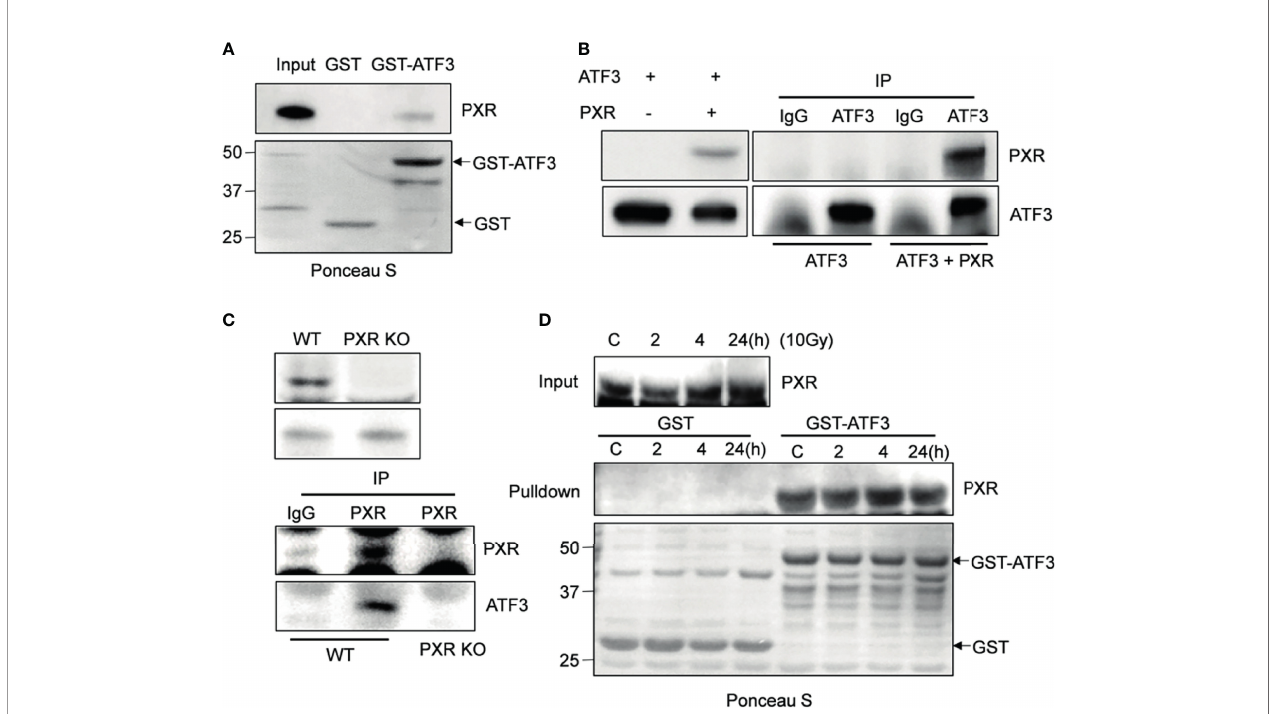
FIGURE 1 | PXR interacts with ATF3. (A) PXR interacted with GST-ATF3. 1 m g GST or GSTATF3 protein was immobilized onto 20 m l glutathione agarose beads, and then incubated with 5 m l in vitro translated PXR. GST-pulldown assay was performed. (B) Interaction between PXR and ATF3 revealed by reciprocal co-IP experiment. H1299 cells in 60 mm3 dish were co-transfected with 3 m g FLAG-PXR, and/or pCG-ATF3. The immunoprecipitation assay was performed using 1 m g IgG antibody or ATF3 antibody. (C) Interaction between PXR and ATF3 con fi rmed by endogenous co-IP assay. 3 mg wild-type and PXR-knockout (KO) LS180 cells were harvested, and PXR antibody (sc-48403) was used for immunoprecipitation, HRP-labeled secondary antibody (ab131368) was used to develop signal. (D) Irradiation does not alter the binding of PXR to ATF3. LS180 cells were treated with 10 Gy of IR and harvested at different time points. 5 m l in vitro translated PXR was incubated with 1 m g immobilized GSTATF3 or GST as indicated for pulldown